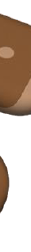
Table 1. Categories and examples of HIFE exercises.